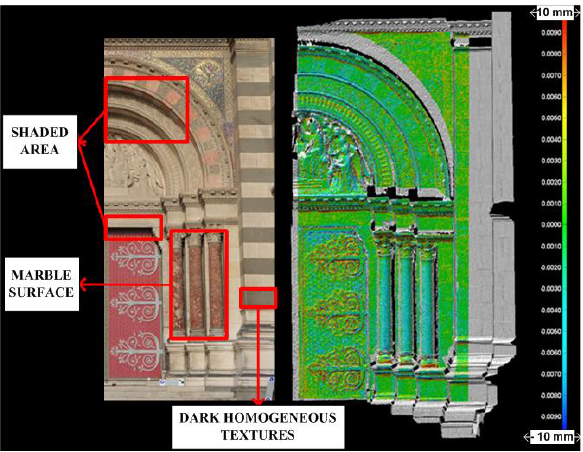
Figure 5. Colour-coded error map delivered by inter- comparison performed on the portal (right) and the resulting problematic areas shown on the colour image (left).